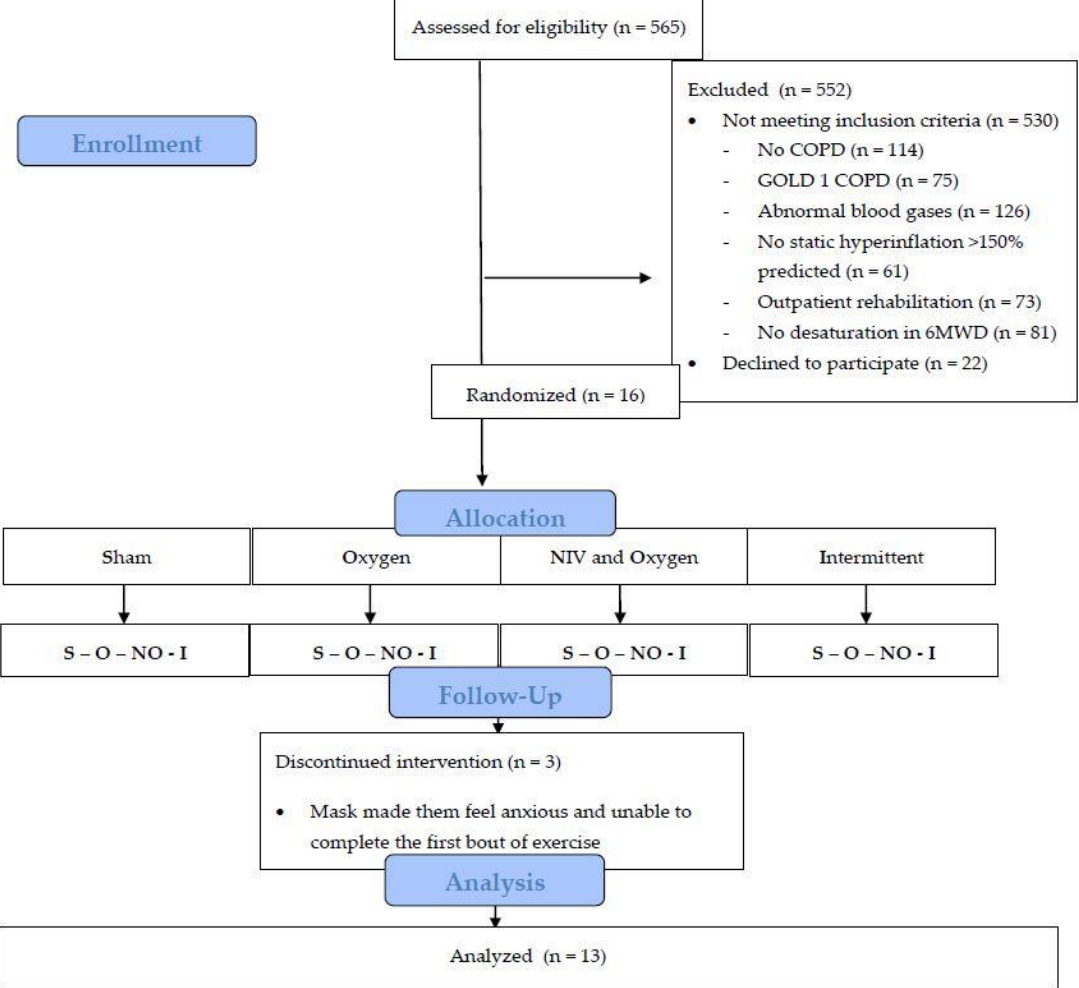
Figure 2. Study flow chart. Abbreviations: COPD = chronic obstructive pulmonary disease, 6MWD = six minute walking distance, NIV = non-invasive ventilation. Table 1. Baseline characteristics n = 13.